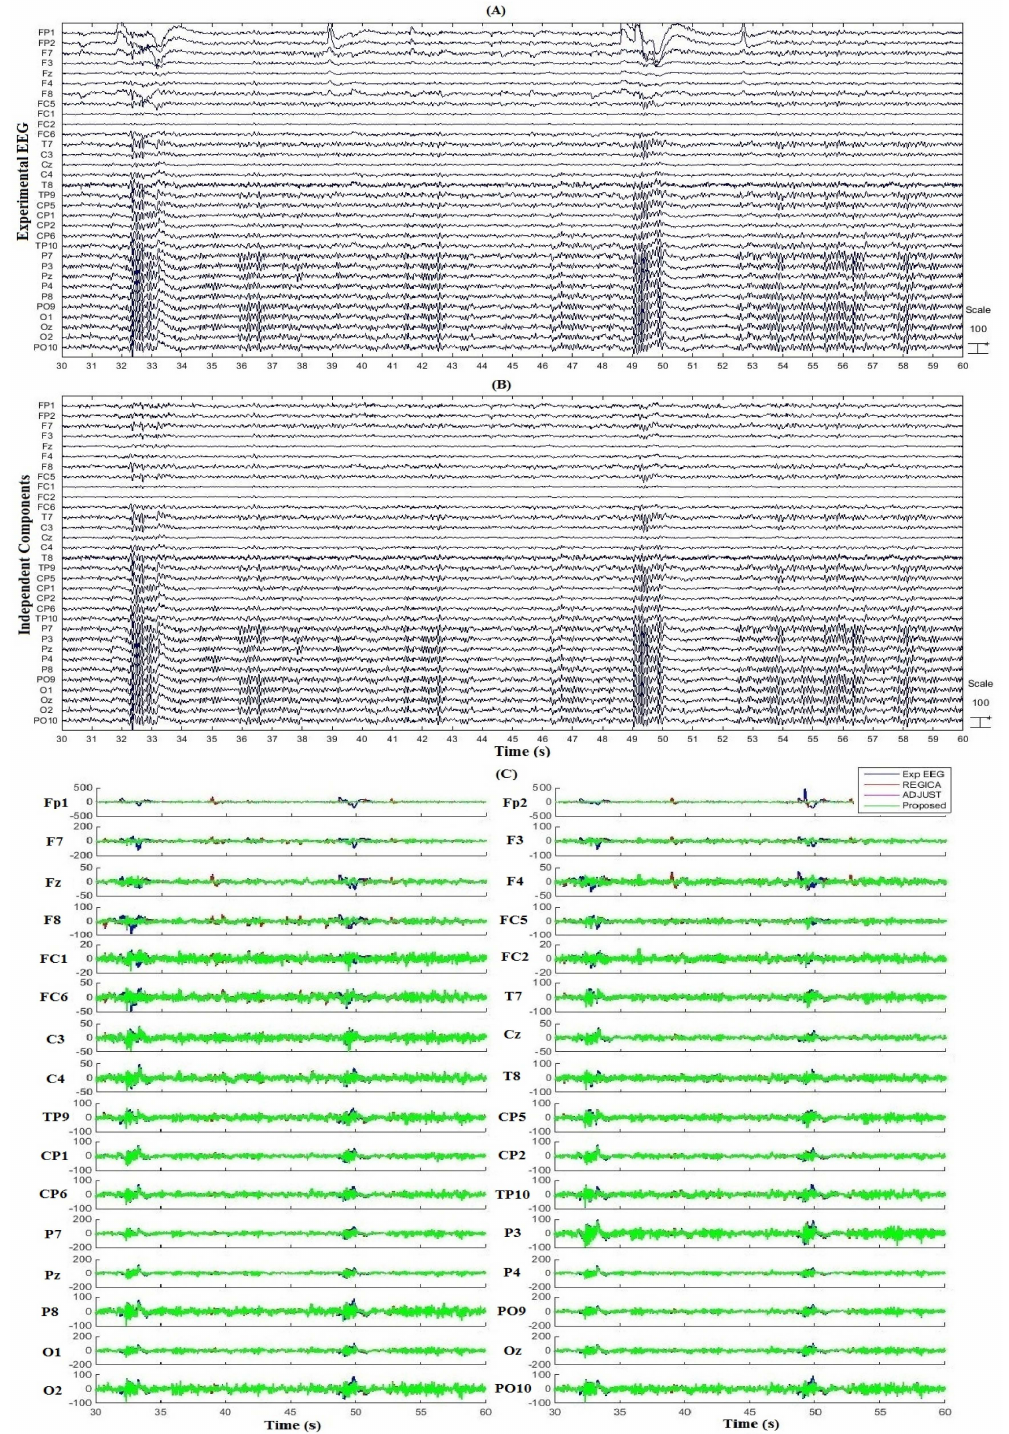
Figure 4. Results on experimental dataset. ( A ) Experimental EEG data for one subject; ( B ) Independent components (ICs) obtained from independent component analysis (ICA) decomposition of EEG data; ( C ) Comparison of the corrected EEG by the proposed algorithm and conventional